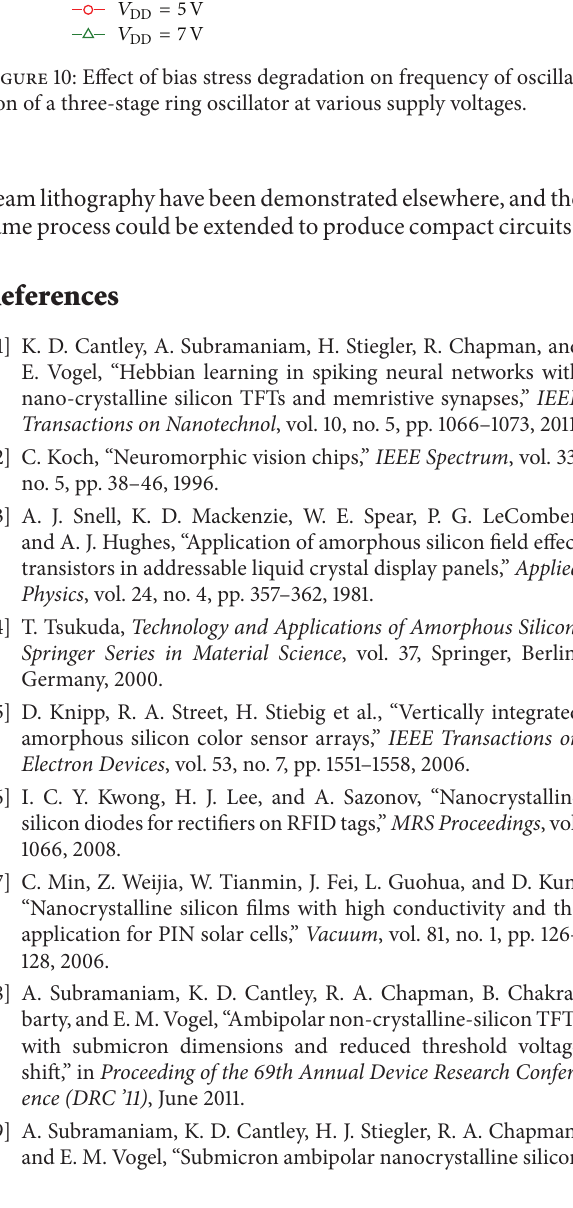
Figure 10: Effect of bias stress degradation on frequency of oscilla- tion of a three-stage ring oscillator at various supply voltages.